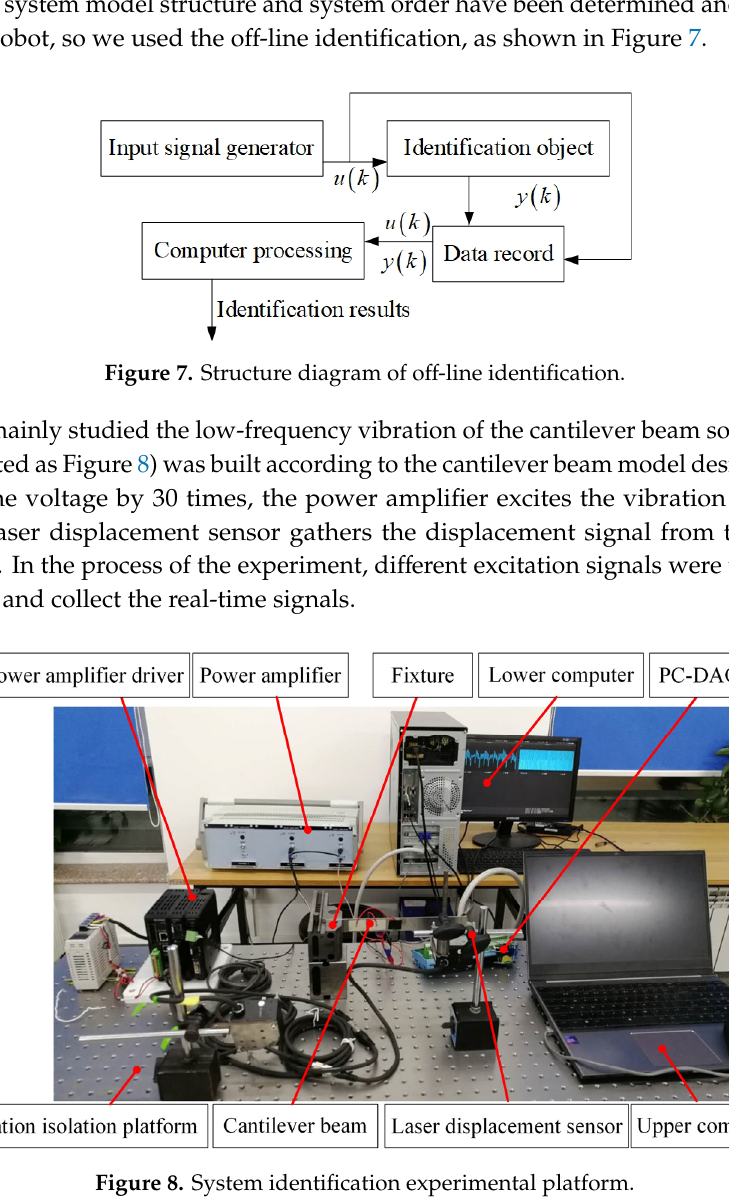
Table 2. Results of different identification system. Excitation Signal